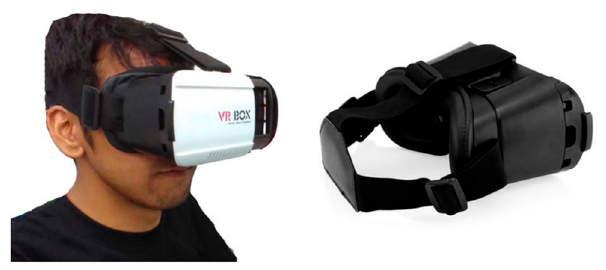
Figure 8. The HMD mode [15].